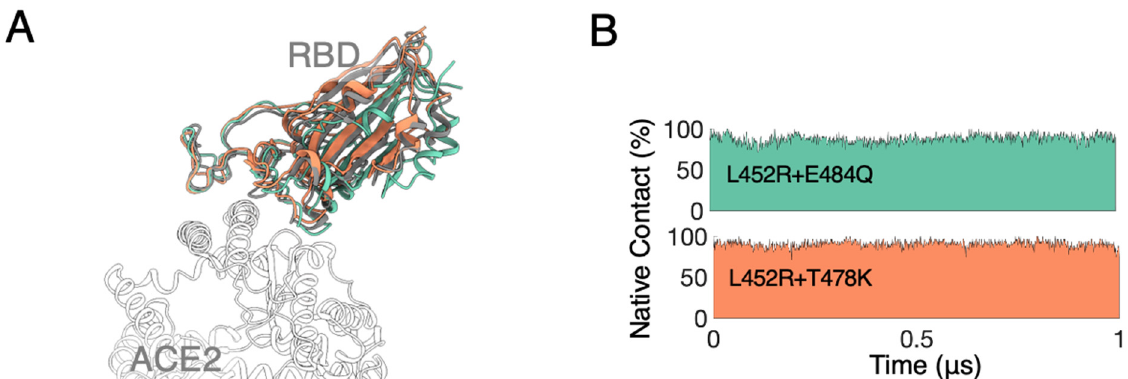
Figure 1. ( A ) ACE2 (white) in complex with WT RBD (grey), RBD mut1 (L452R + E484Q and indigo) and RBD mut2 (L452R + T478K and orange). Complexes were aligned according to ACE2. ( B ) Native contacts between mutated RBDs and ACE2, taking the WT complex as the reference.